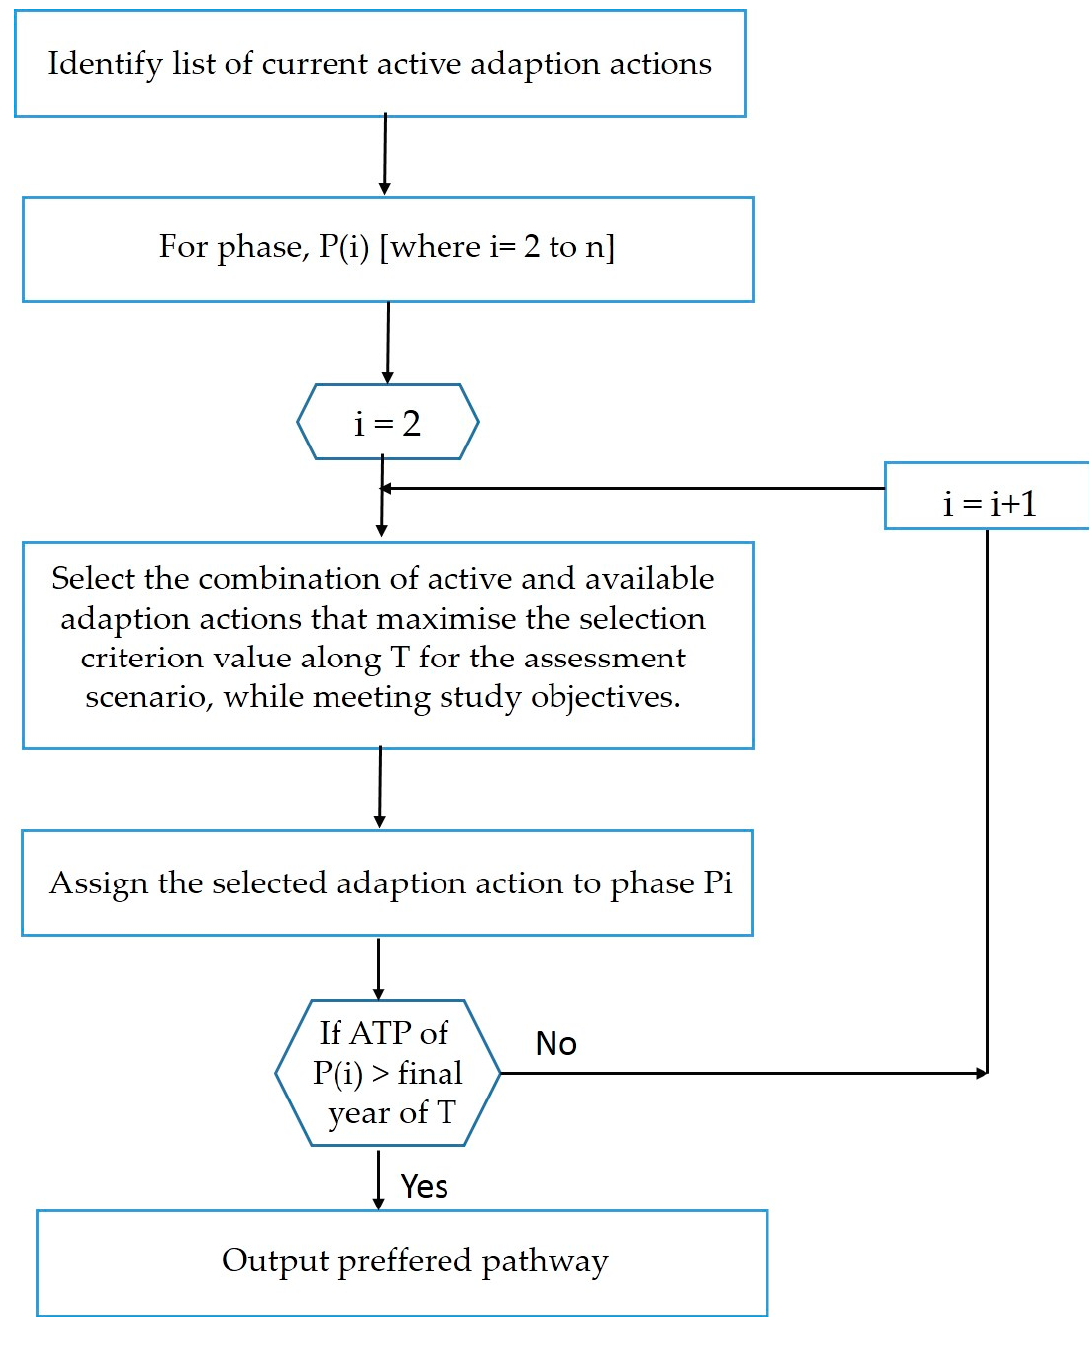
Figure 3. BU Sequencing approach.